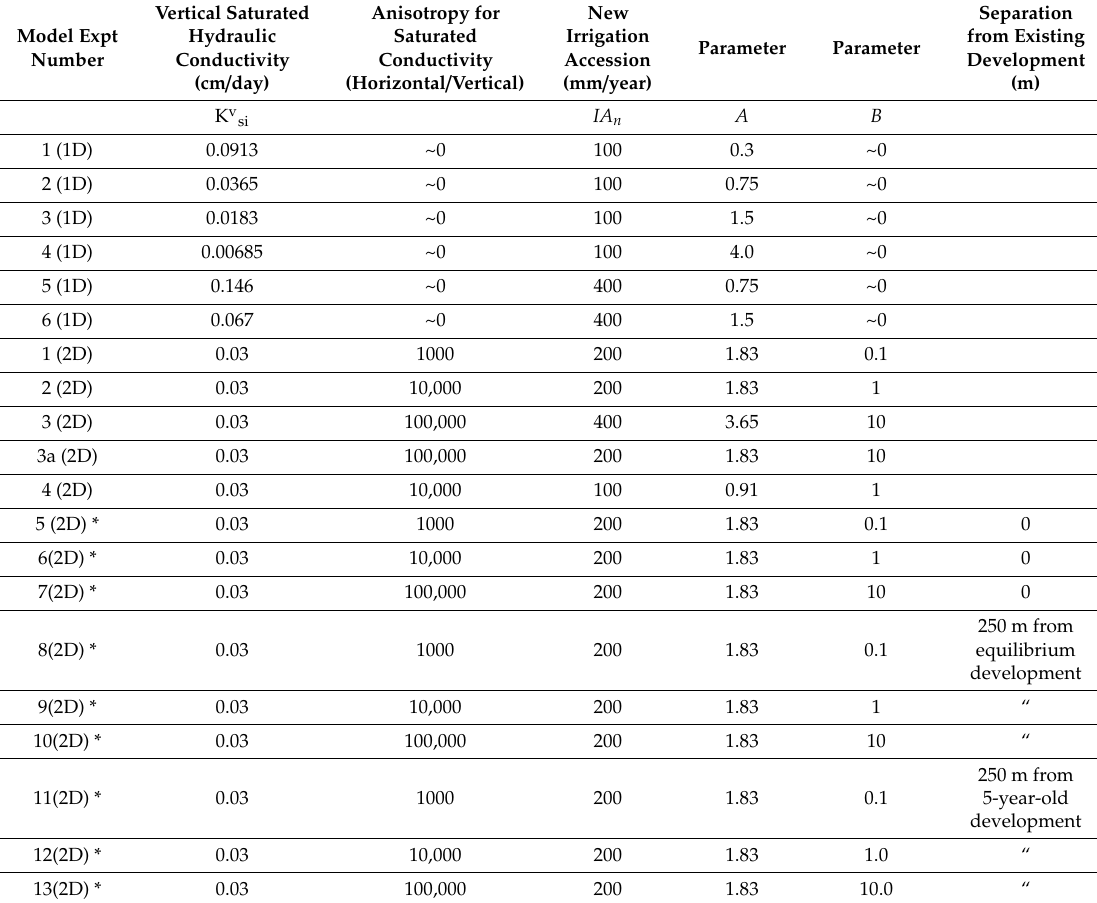
Table 3. Benchmarking